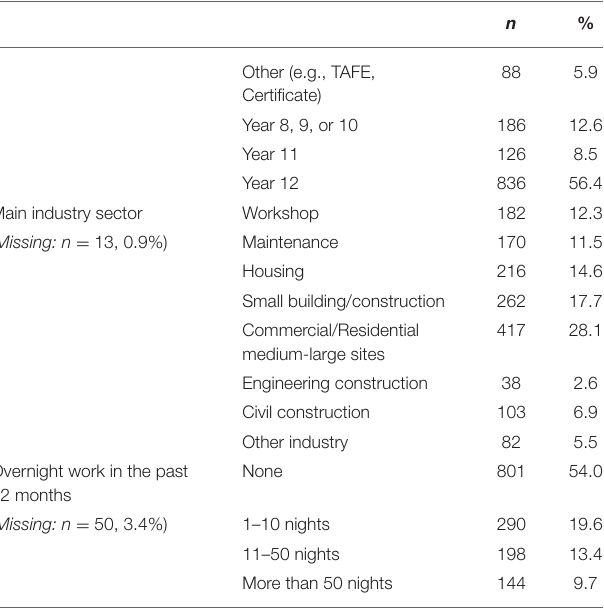
TABLE 1 | Demographic variables and apprenticeship background ( N =